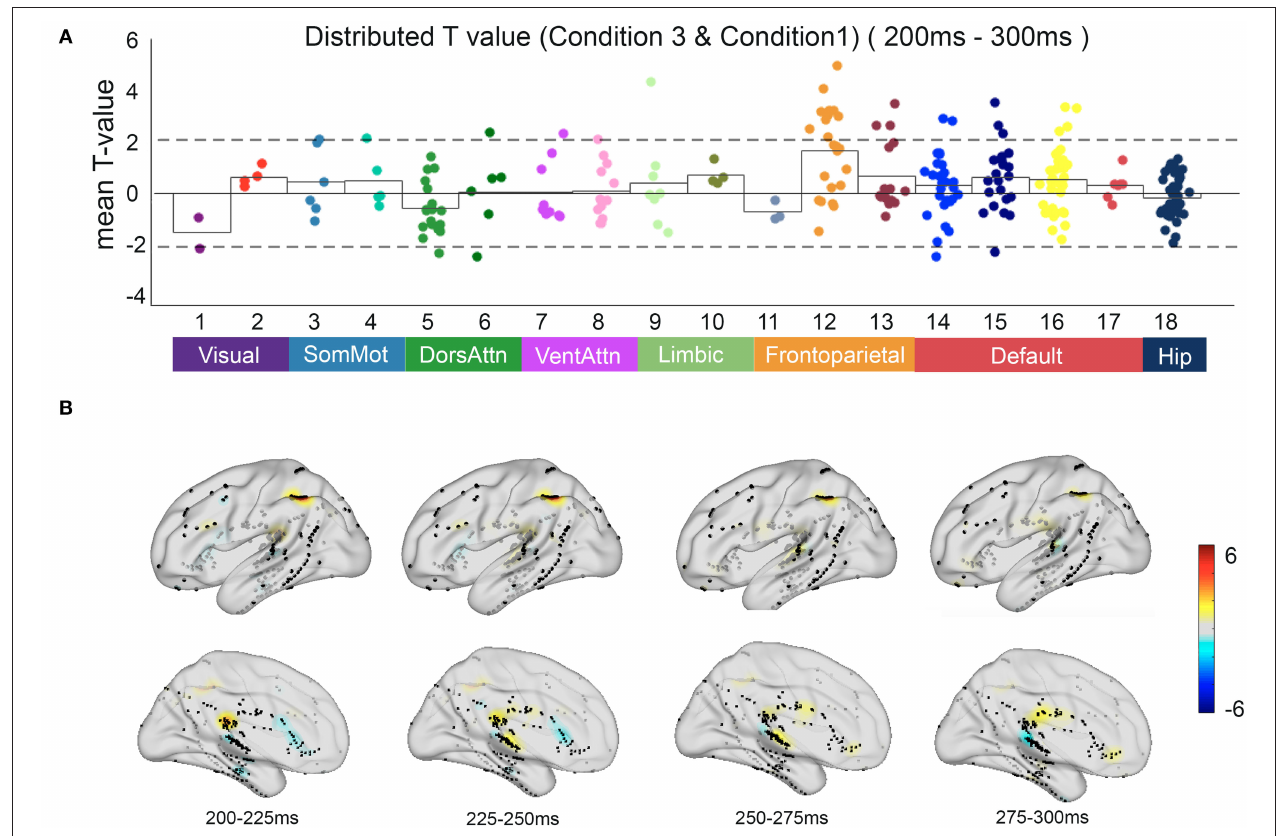
FIGURE 6 | The neural response in functional networks and the spatiotemporal map of relevant incongruent condition. (A) Mean t -value distributed across 17 networks and hippocampus during 200–300ms between the relevant incongruent condition and congruent condition. Significant responses were detected on frontoparietal control network and default mode network ( t -value > 2, p < 0.05). (B) The t -value map shows dynamics between the relevant incongruent condition and congruent condition. Color intensity indicates t -value of positive (red) or negative